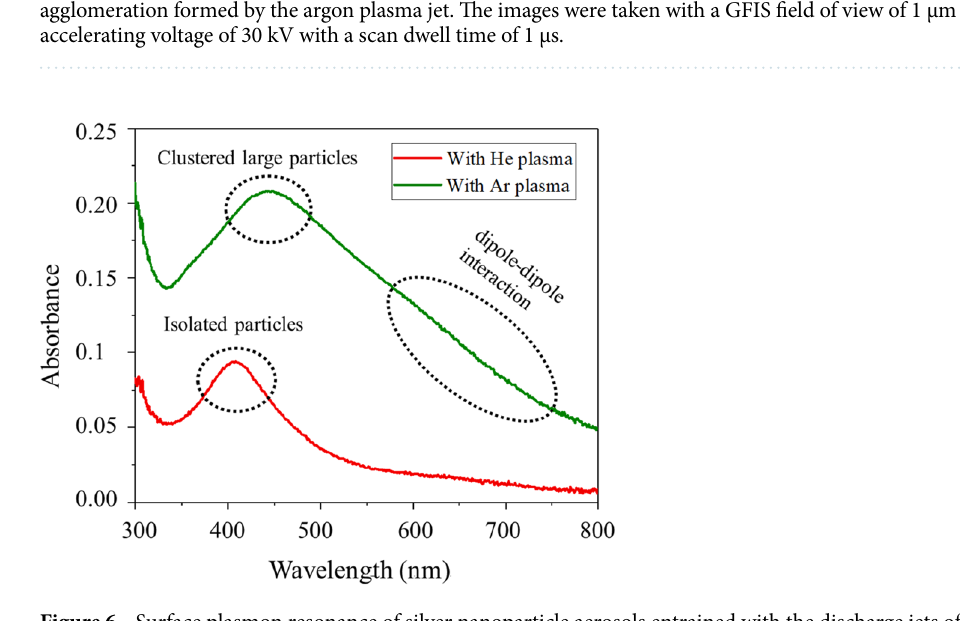
Figure 6. Surface plasmon resonance of silver nanoparticle aerosols entrained with the discharge jets of argon and helium and deposited on a glass slide. The doted circles indicate various plasmonic features of the deposited